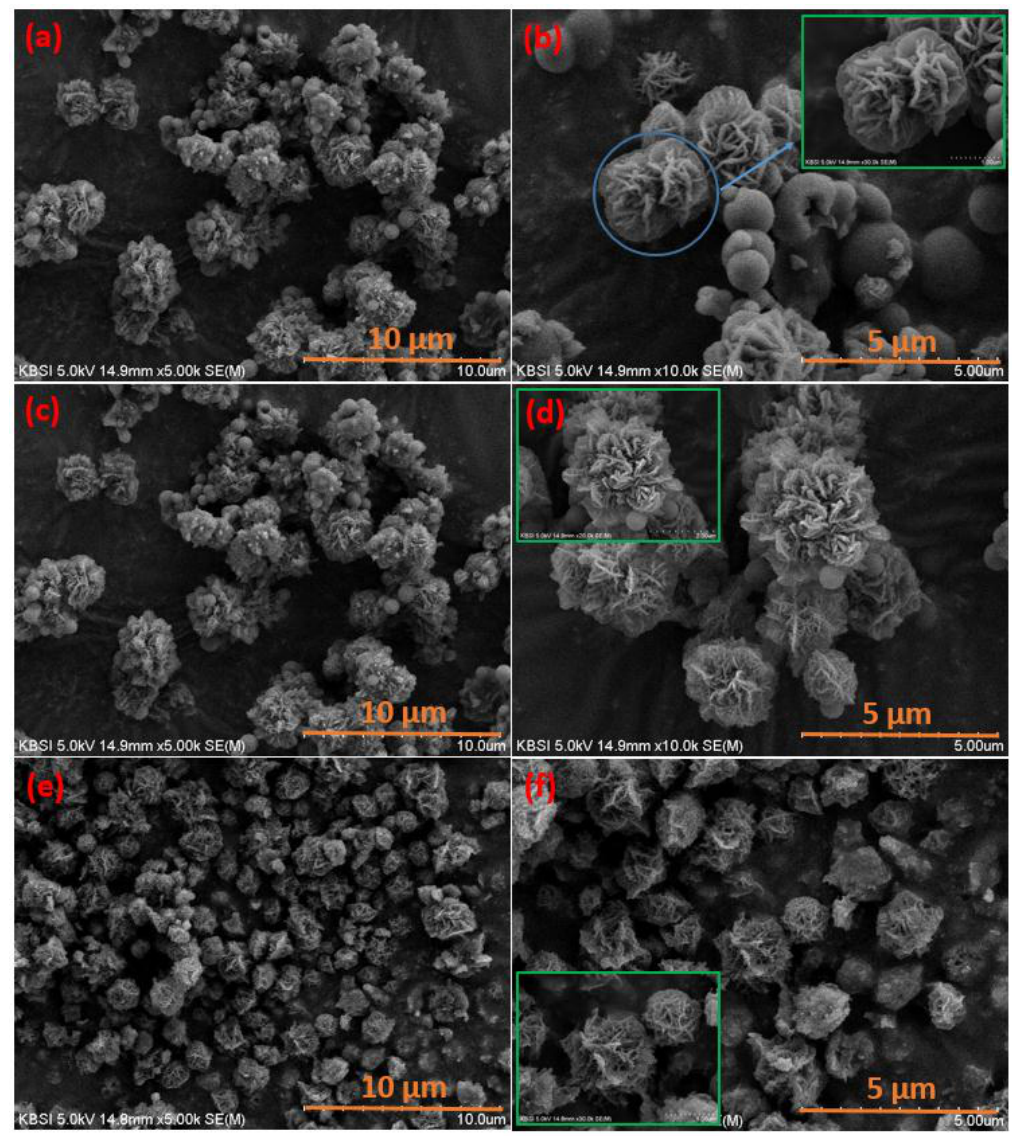
Figure 5. HR-SEM images: Cu-MnS with 1PVP, Cu-MnS with 2PVP and Cu-MnS with 3PVP ( a , c , e ) low magnification images and ( b , d , f ) high-magnifications images.